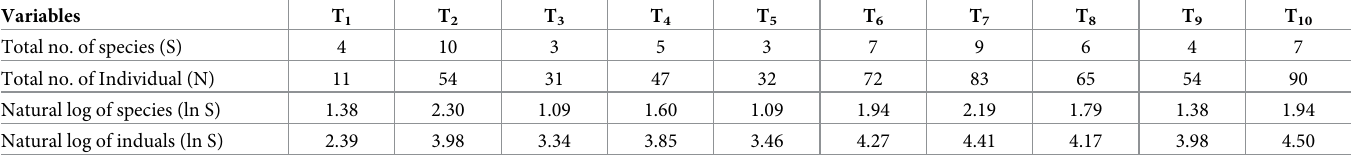
tree dimension diversity and tree position diversity. Forest is the key indicator of current study. The commonly used diversity indices include Shannon Weiner index ( H’ ), Simpson’s diversity ( D ), Pielou’s (J) and Margalef index ( SR )index were utilized to assess tree species diversity.